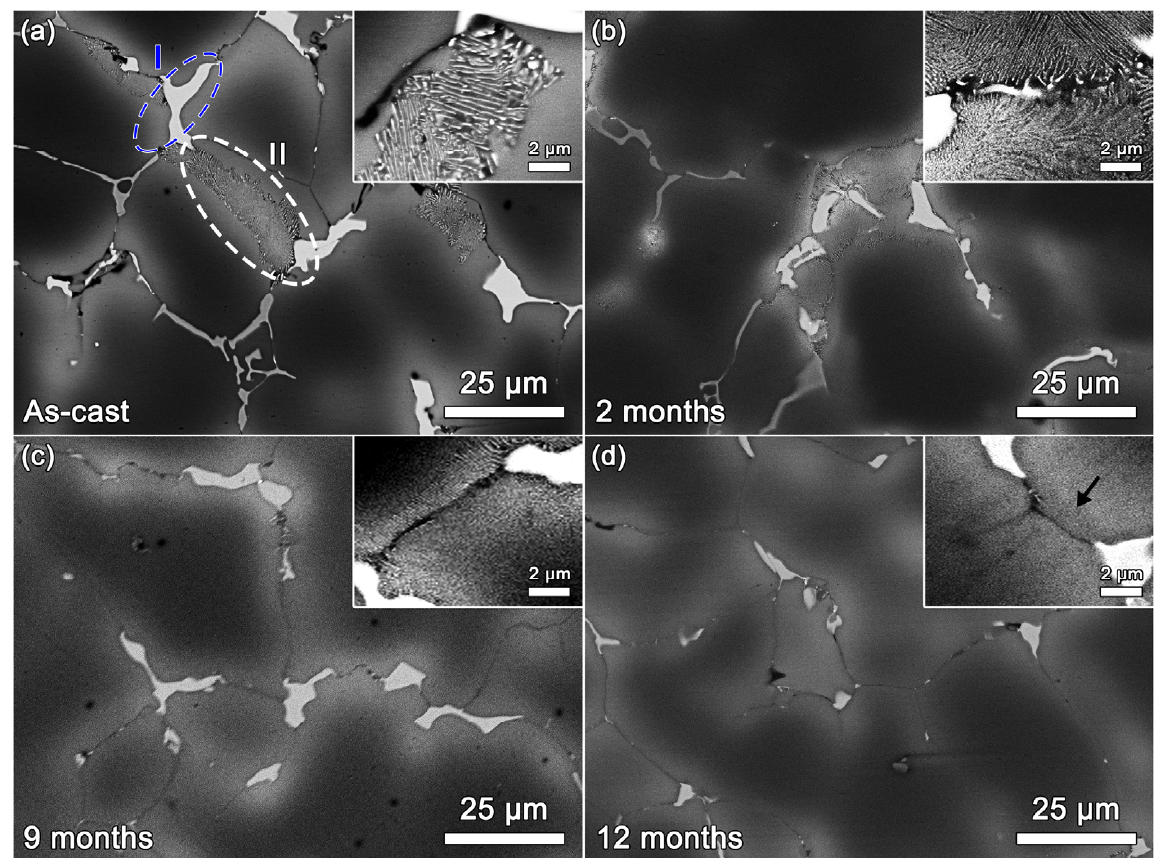
Figure 3. Typical BSE images of Al-20Zn-3Cu: ( a ) as-cast, ( b ) 2 months, ( c ) 9 months, and ( d ) 12 months. The insets show the decreased volume fraction of the eutectoid lamellar structure consisting of the α -Al and the η -Zn phase.